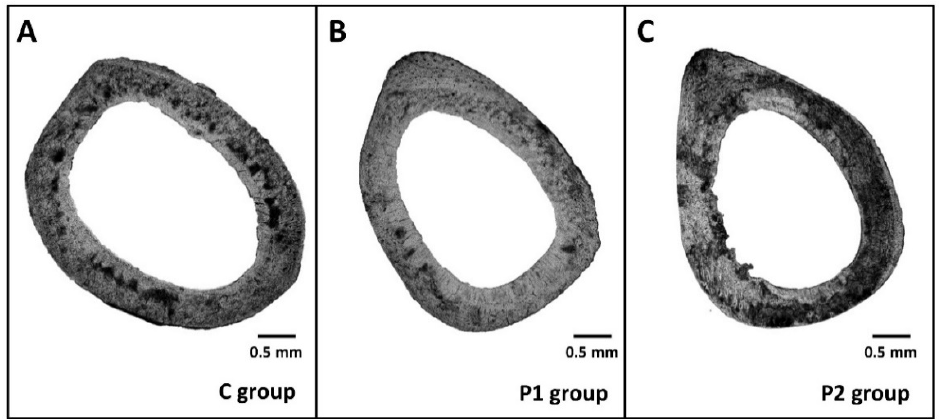
Figure 3. Cortical bone microscopic structure of rats from C ( A ), P1 ( B ) and P2 ( C ) groups.